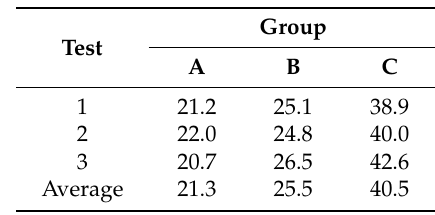
Table 2. 28-day cubic compressive strength of concrete (MPa).